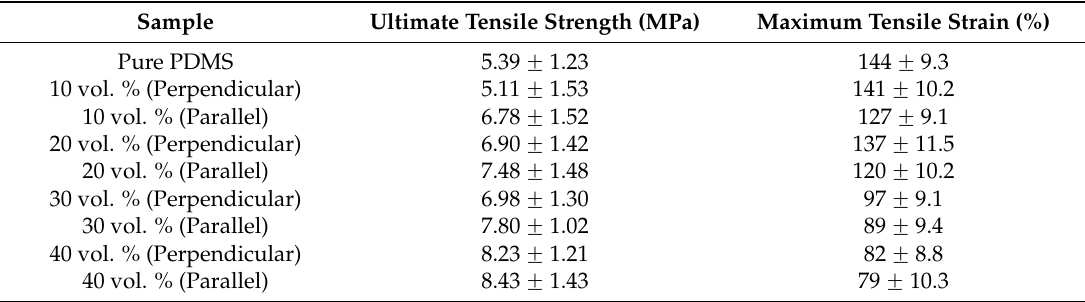
Figure 6. ( a ) Stress-strain curve of tensile strength testing for pure PDMS and SNP/PDMS composites; and ( b ) tensile stress ratio of parallel to perpendicular SNP configurations. Table 1. Maximum tensile strength and strain of PDMS and SNP/PDMS composites.